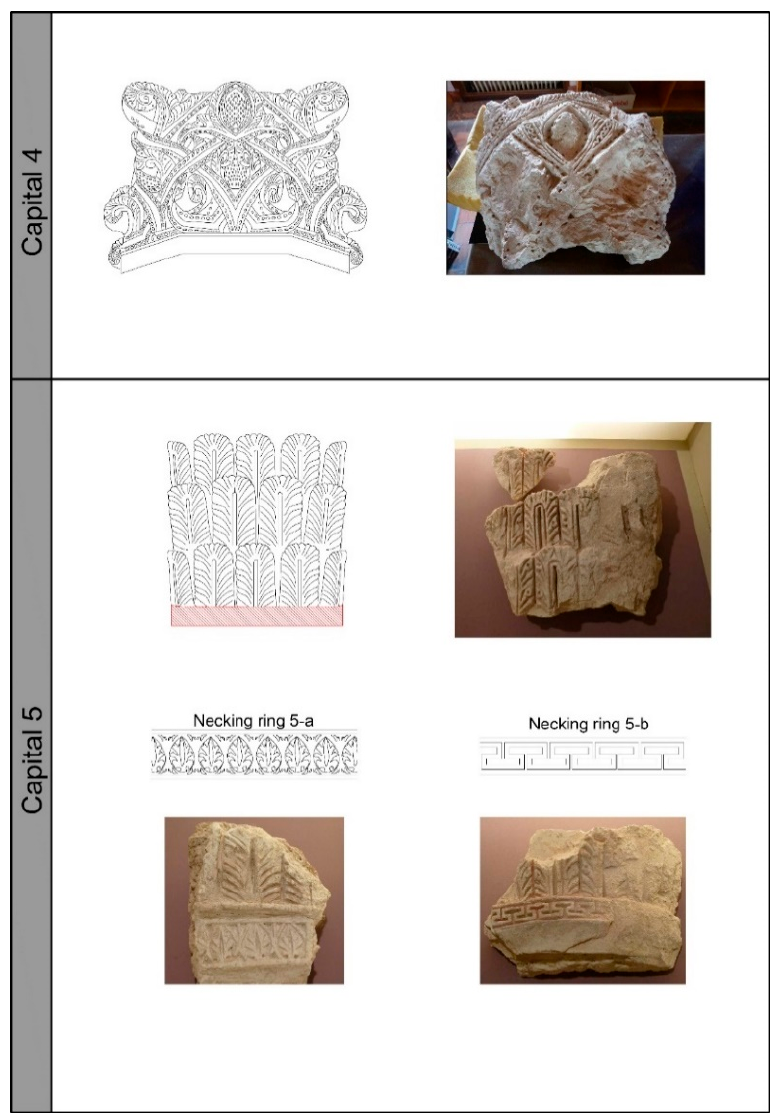
Figure 9. Fragments and possible reconstruction of the capitals of Molina de Aragón Synagogue. Created by author.